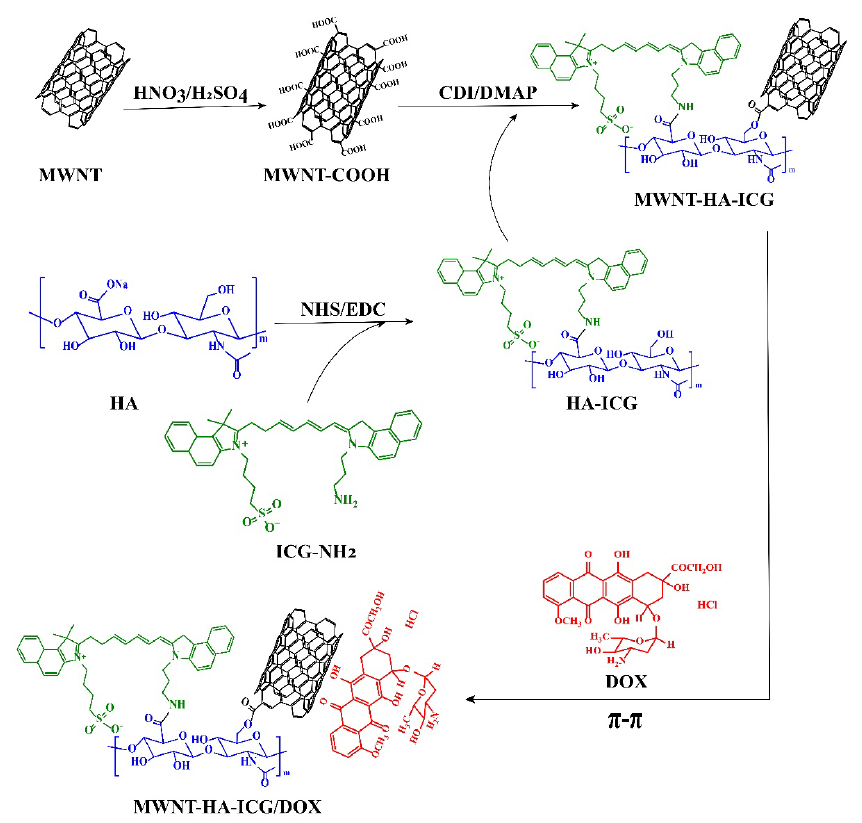
Figure 1. Synthesis route of MWNT-HA-ICG/DOX.